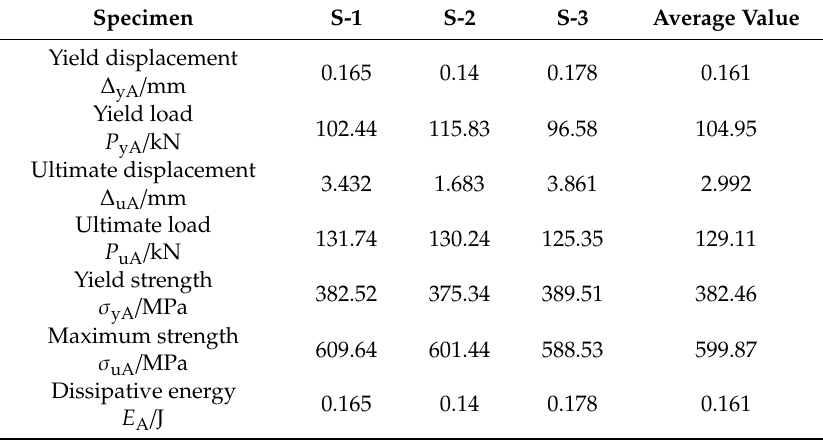
Table 2. Results of monotonic tensile specimens of welded plate joints.